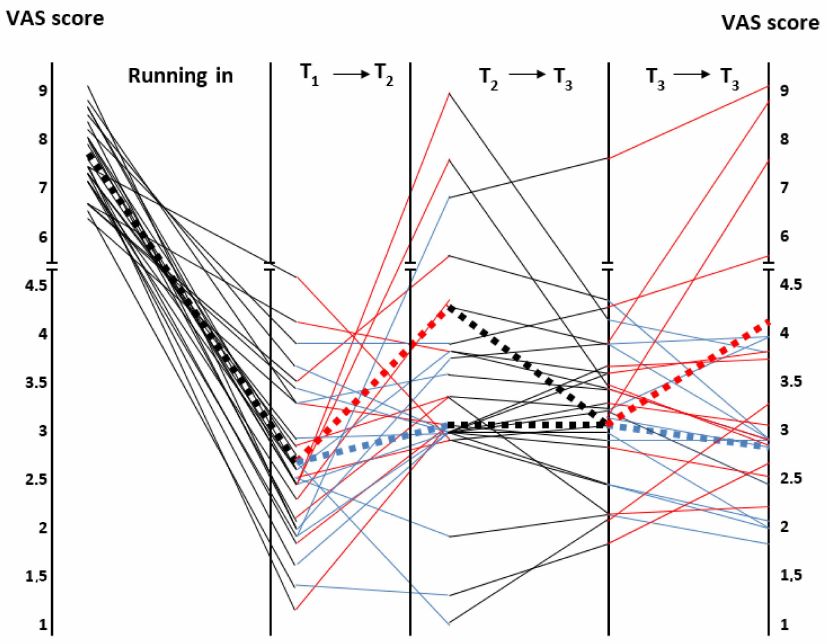
Figure 3. Graphical representation of the VAS score changes from the beginning to the end of the study. Black continuous lines refer to the phases with low FODMAP-GFD and red and blue continuous lines correspond to the gluten and rice challenge, respectively. The ends of each dotted line represent the mean of the VAS values obtained at the beginning and the end of each phase of the